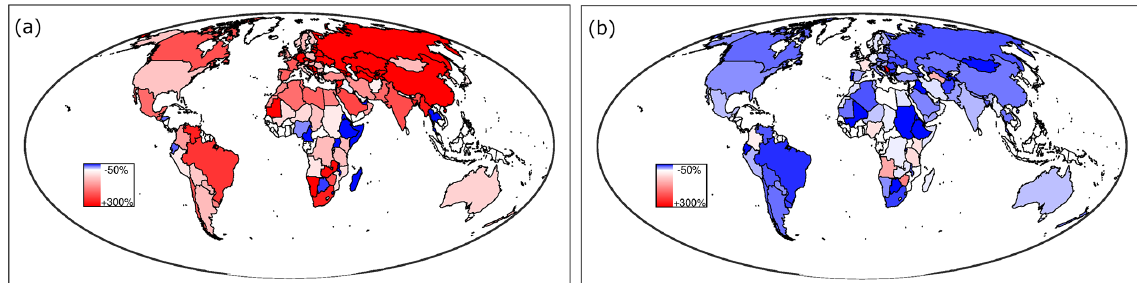
Figure 4. Relative change in the uWFp of wheat in 1961 (a) and 2016 (b) with respect to the average in 1996–2005, using identical color ranges: red (blue) colors identify higher (lower) values and color intensity scales with change values. (Maps are created with MATLAB®R14 software, Mapping Toolbox v.2.0.3.)